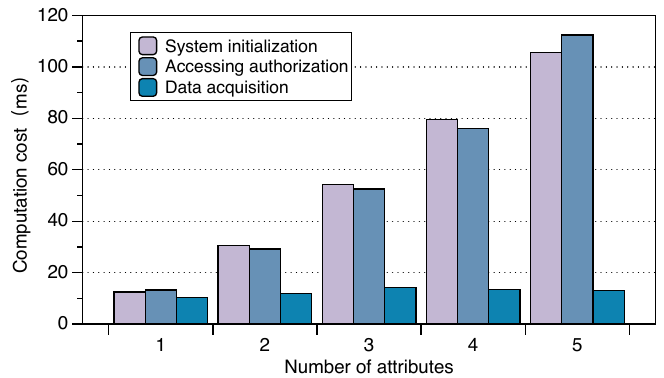
Figure 7. The time spent on accessing